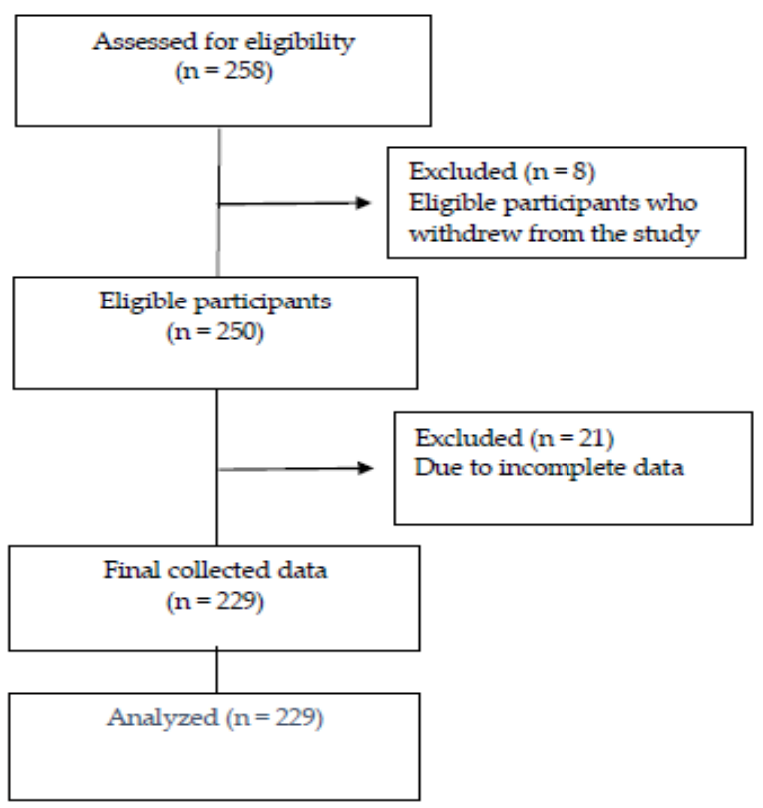
Figure 3. Flow chart of the study.